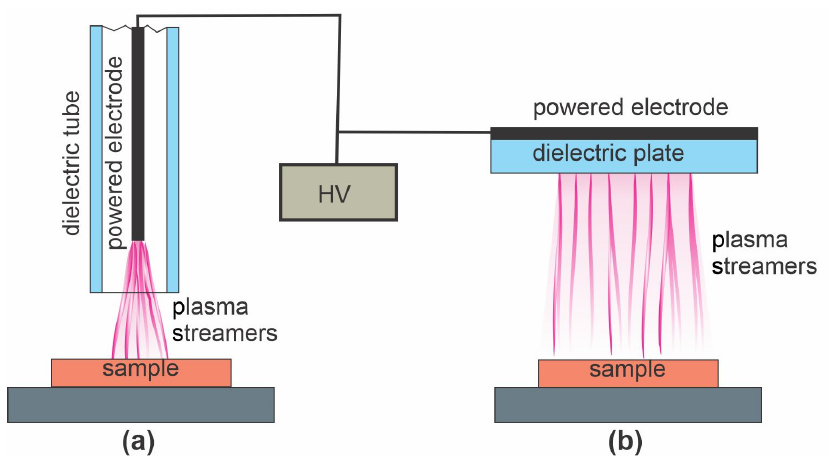
Figure 6. ( a ) The atmospheric plasma jet and ( b ) plasma sustained by dielectric barrier discharge (DBD) discharge with a high-voltage generator at a frequency below 10 kHz. The sample holder may or may not be grounded.